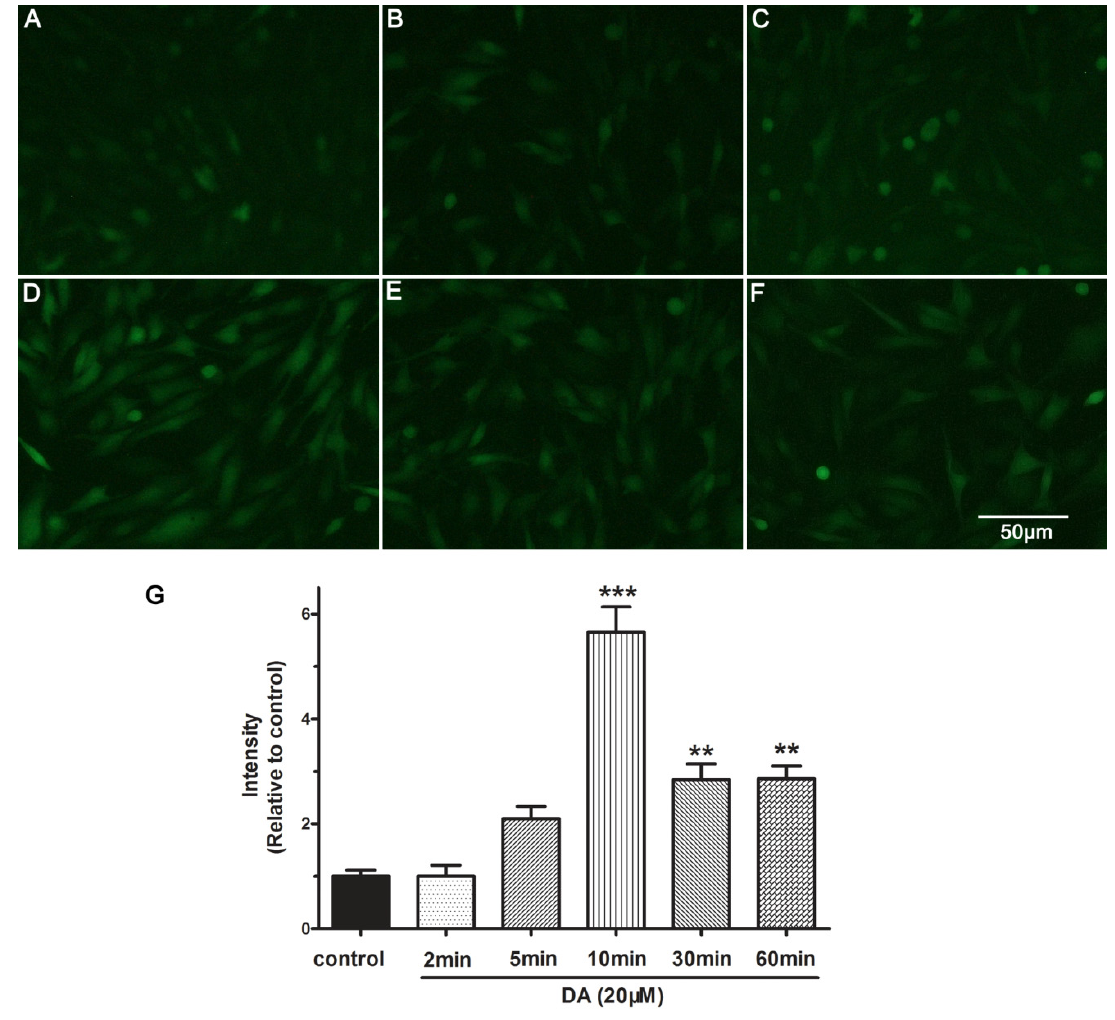
Figure 6. DA -induced NO production in PAECs within 60 min. NO production was visualized with fluorescence intensity. PAECs were treated with DA for different periods ( A ) 0 min (control); ( B ) 2 min; ( C ) 5 min; ( D ) 10 min; ( E ) 30 min; ( F ) 60 min. Results are presented as the mean ± SEM ( n = 5) ( G ). ** p < 0.01 and *** p < 0.001 compared with the control